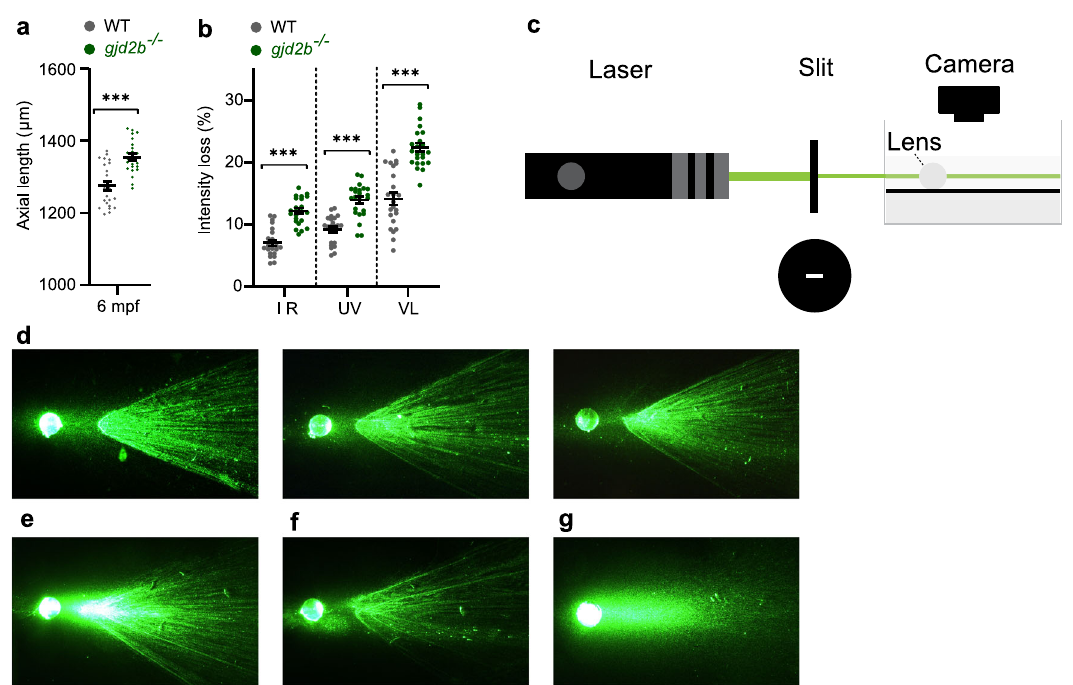
Fig. 4 Late-onset axial growth in gjd2b (Cx35.1) mutants is induced by retinal image degradation. a SD-OCT shows a signi fi cant increase in axial length in 6 mpf gjd2b (Cx35.1) mutants ( n = 24 eyes). b Loss of lenticular projection intensity of isolated mutant lenses ( n = 24 eyes), the following wavelengths were used: IR light (940 nm), UV light (365 nm), and broad-spectrum visible light (380 – 760 nm). c Schematic illustration of the ex vivo lenticular light propagation setup. d Examples of light propagation in three isolated 6 mpf WT control lenses. e – g Examples of light scattering and multifocality by two moderately cataractous lenses ( e ) and ( f ) and light diffusion by a severely cataractous lens ( g ) of the 6 mpf gjd2b (Cx35.1) mutant. Error bars: